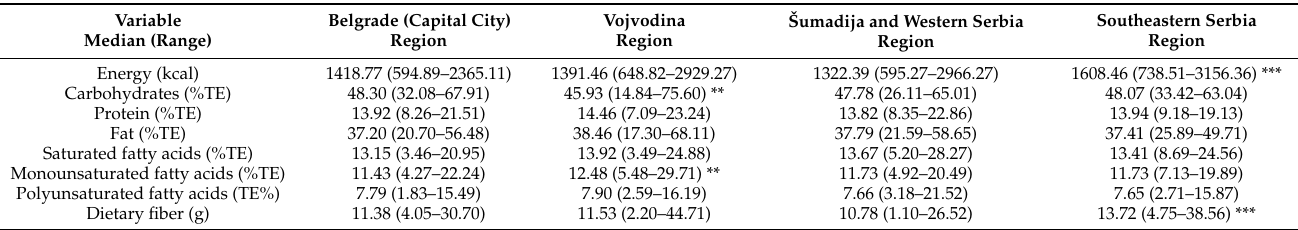
Table 5. Distribution of daily energy and macronutrient intake across geographical areas in a nationally representative sample of children 1–9 years of age living in Serbia ( n = 576).